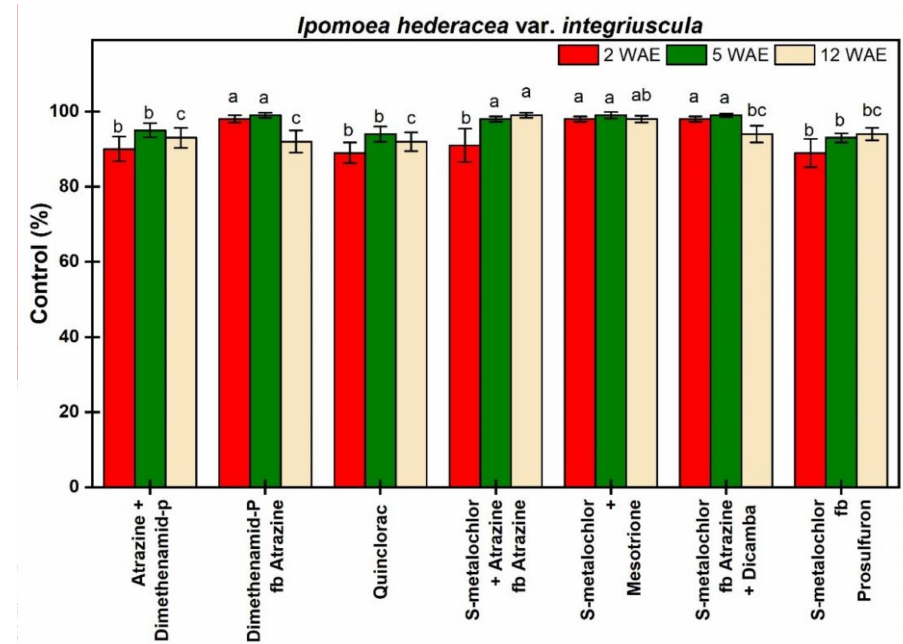
Figure 2. Ipomoea hederacea var. integriuscula control with di ff erent herbicide treatments at 2, 5, and 12 weeks after emergence (WAE). Data were analyzed separately for each WAE. Data were pooled over three years. The same letters on bars indicate no significant di ff erences at p < 0.05, according to Fisher’s least significant di ff erence